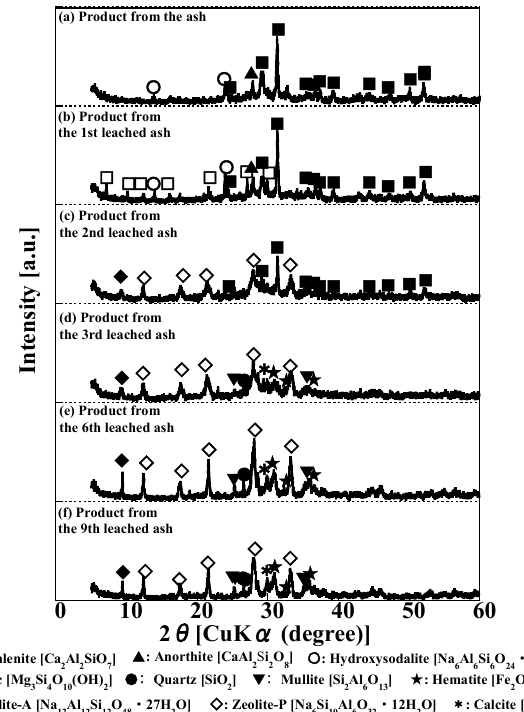
Figure 3. XRD patterns of products synthesized from ashes leached with 1 M HCl solution, as a function of the number of leaching treatments.